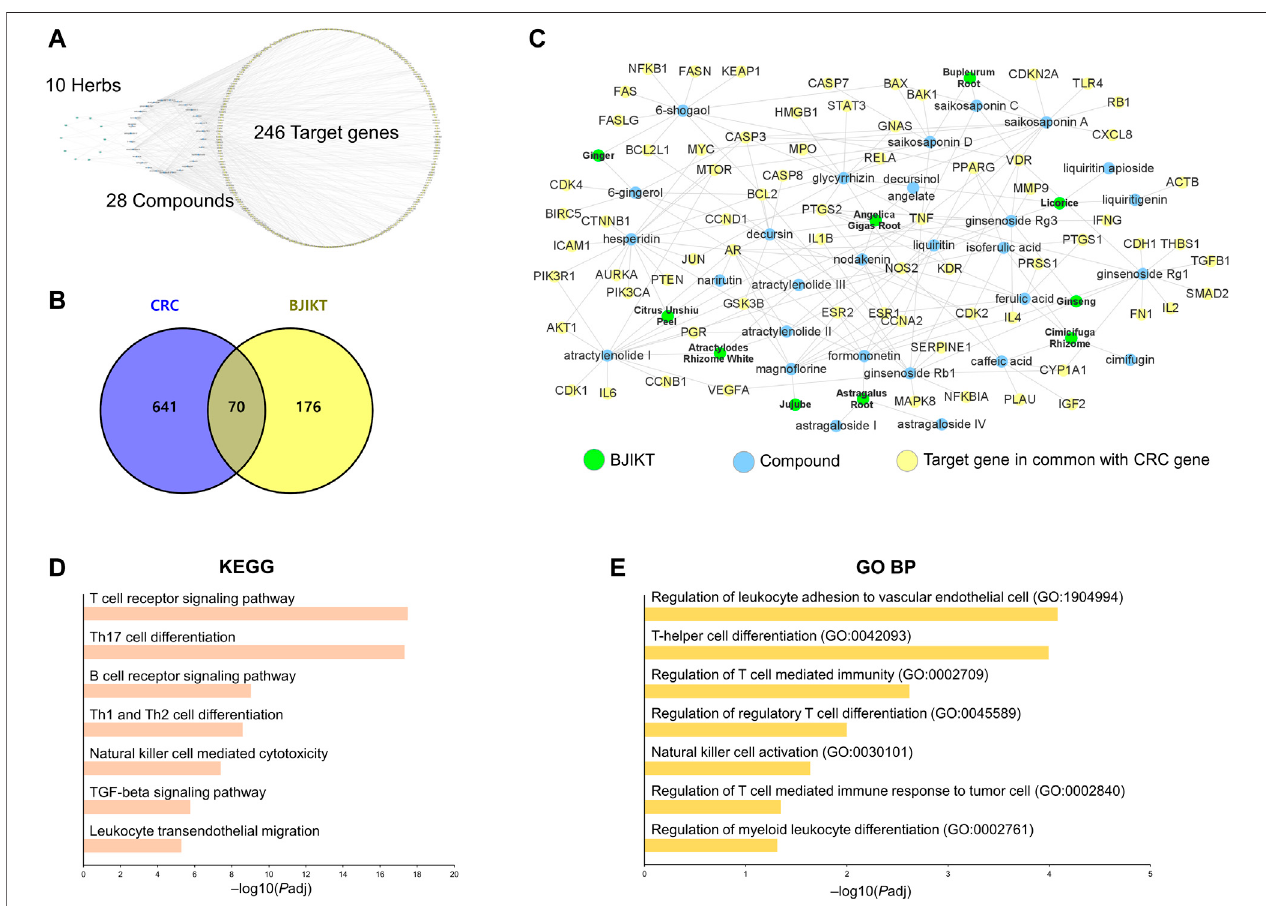
FIGURE 7 | Network pharmacological analysis of BJIKT. (A) Network of 10 herbs, 28 major compounds, and 246 target genes of BJIKT. The potential targets of major compounds were predicted using the Encyclopedia of Traditional Chinese Medicine (ETCM) and Symptom Mapping (SymMap) databases. (B) Venn diagram for 711 CRC-related genes and 246 target genes of BJIKT. The 70 genes were common. (C) Reconstructed BJIKT network with the common 70 target genes. (D,E) Pathway enrichment analysis for the common 70 target genes of BJIKT with the Kyoto Encyclopedia of Genes and Genomes (KEGG) (D) and Gene Ontology Biological Process (GO BP) (E) gene